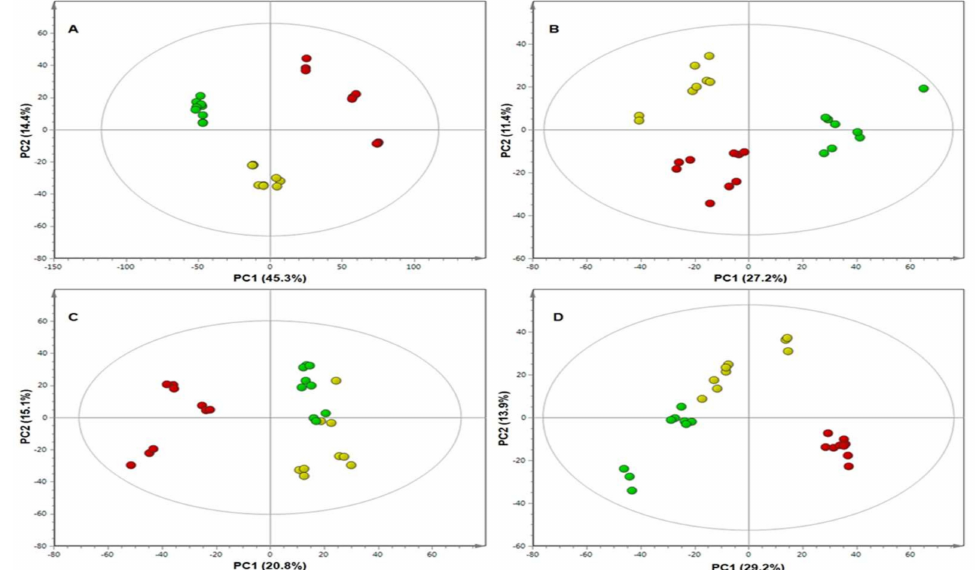
Figure 3. Principal component analysis (PCA) scores plots of negative ionisation data for the susceptible (S) , tomato plants showing the di ff erential clustering of all three di ff erent treatment groups at ( A ) day 8, ( B ) day 15, ( C ) day 25 and ( D ) day 35. Key: Con , (green); WF , (yellow); WF + Vir (red). PC, principal